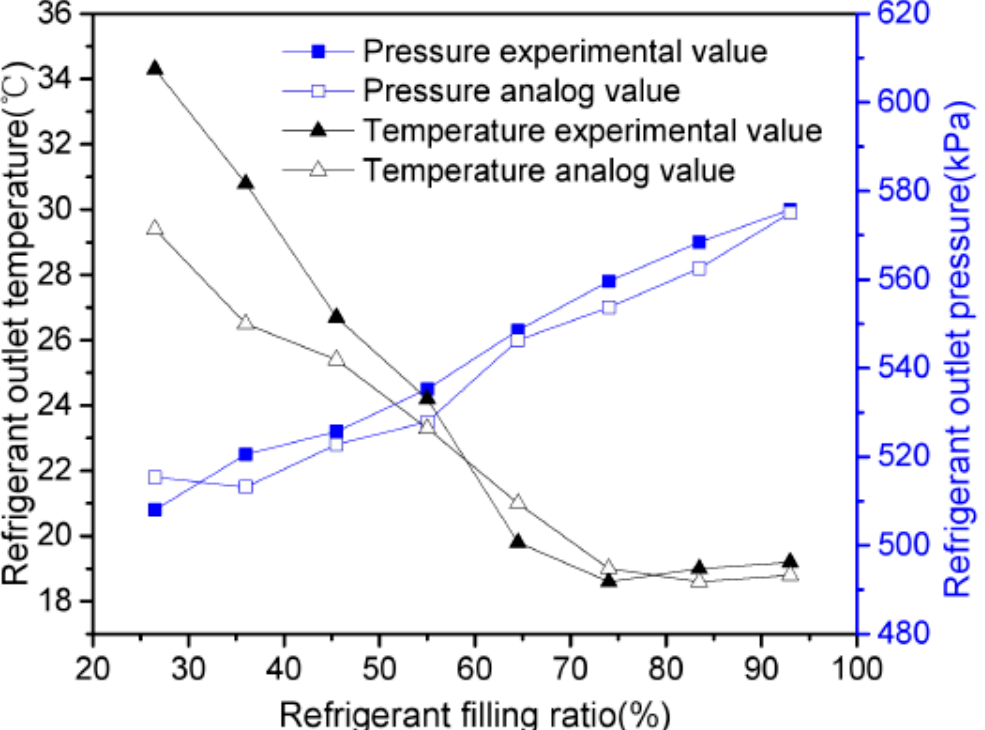
Figure 8. Comparison of temperature and pressure of refrigerant at the outlet of the evaporator.